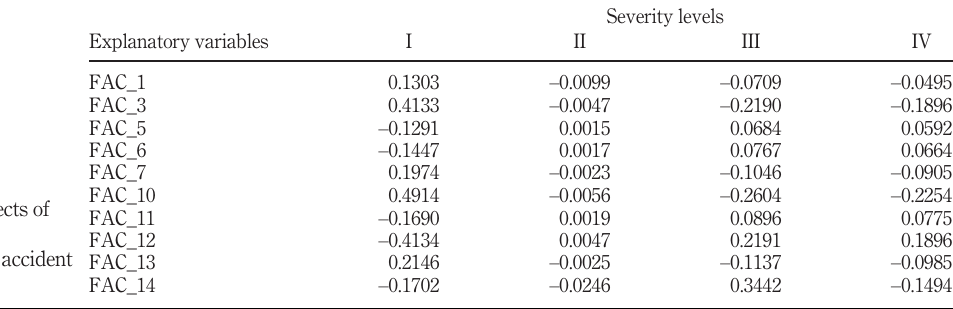
Table 5. Marginal effects of explanatory variables for accident